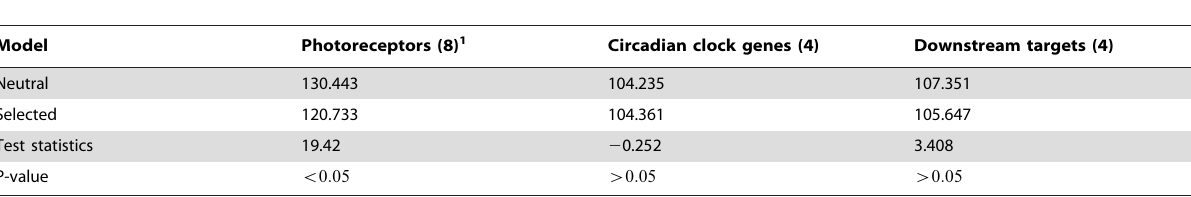
Table 3. Likelihood values from the mlHKA test of the different group of photoperiodic genes.